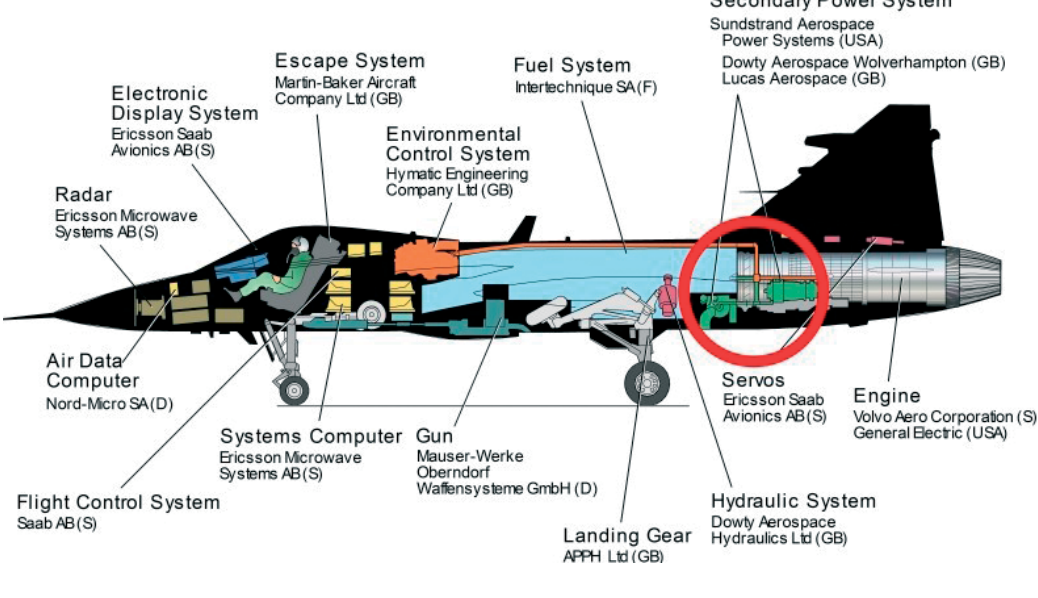
Figure 3: Major systems ofJAS39